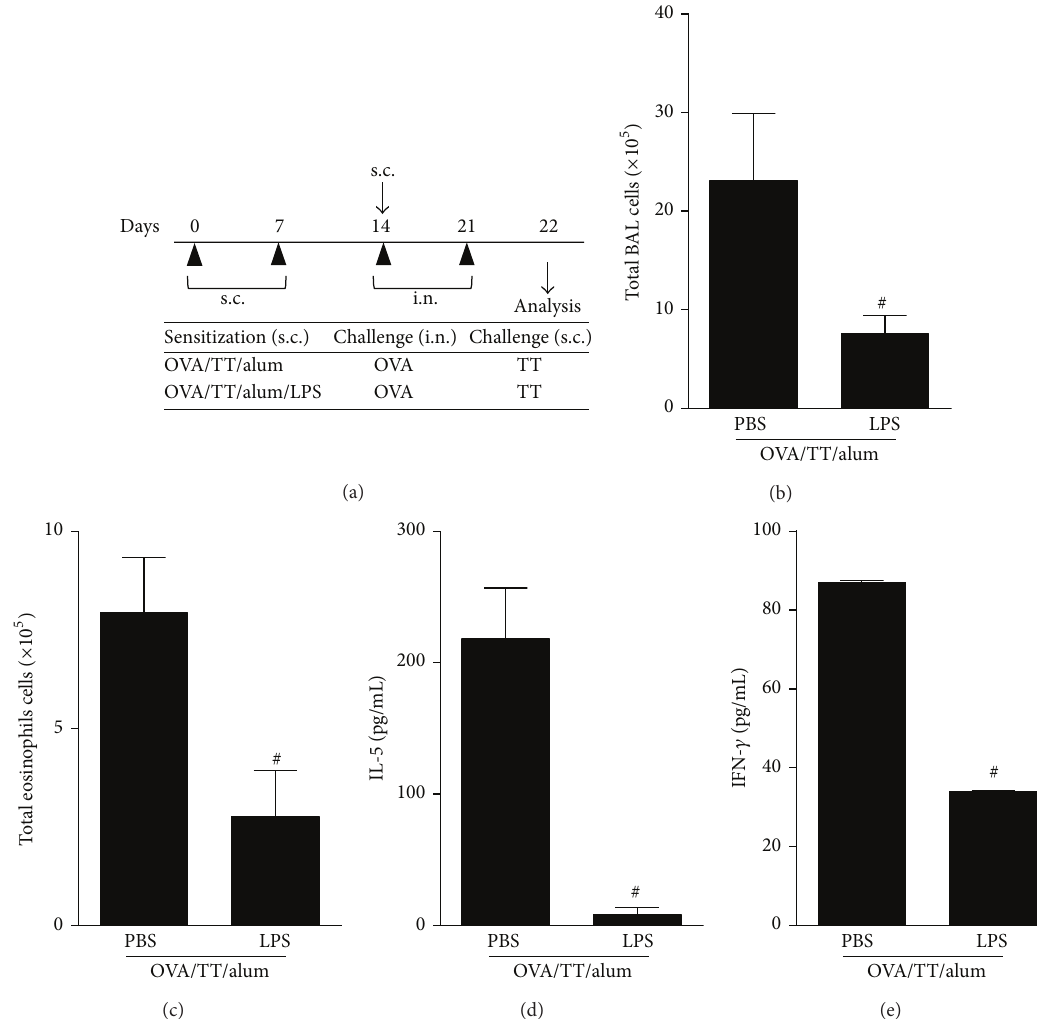
Figure 4: Effects of adsorption of LPS onto OVA/TT/alum sensitization on OVA-induced airway allergic inflammation. (a) Protocol: BALB/c mice sensitized with s.c. OVA/TT/alum in the presence or not of LPS (10 𝜇 g) on days 0 and 7 and challenged with i.n. OVA on days 14 and 21. Samples obtained on day 22. (b) Total number of cells and (c) eosinophils in BAL: ((d) and (e)) levels of IL-5 and IFN- 𝛾 in BAL. Data shown as mean ± SE, one-way ANOVA: # 𝑃 < 0.05 ; different from OVA/TT/alum/PBS group ( 𝑛 = 5 ), and experiment was repeated